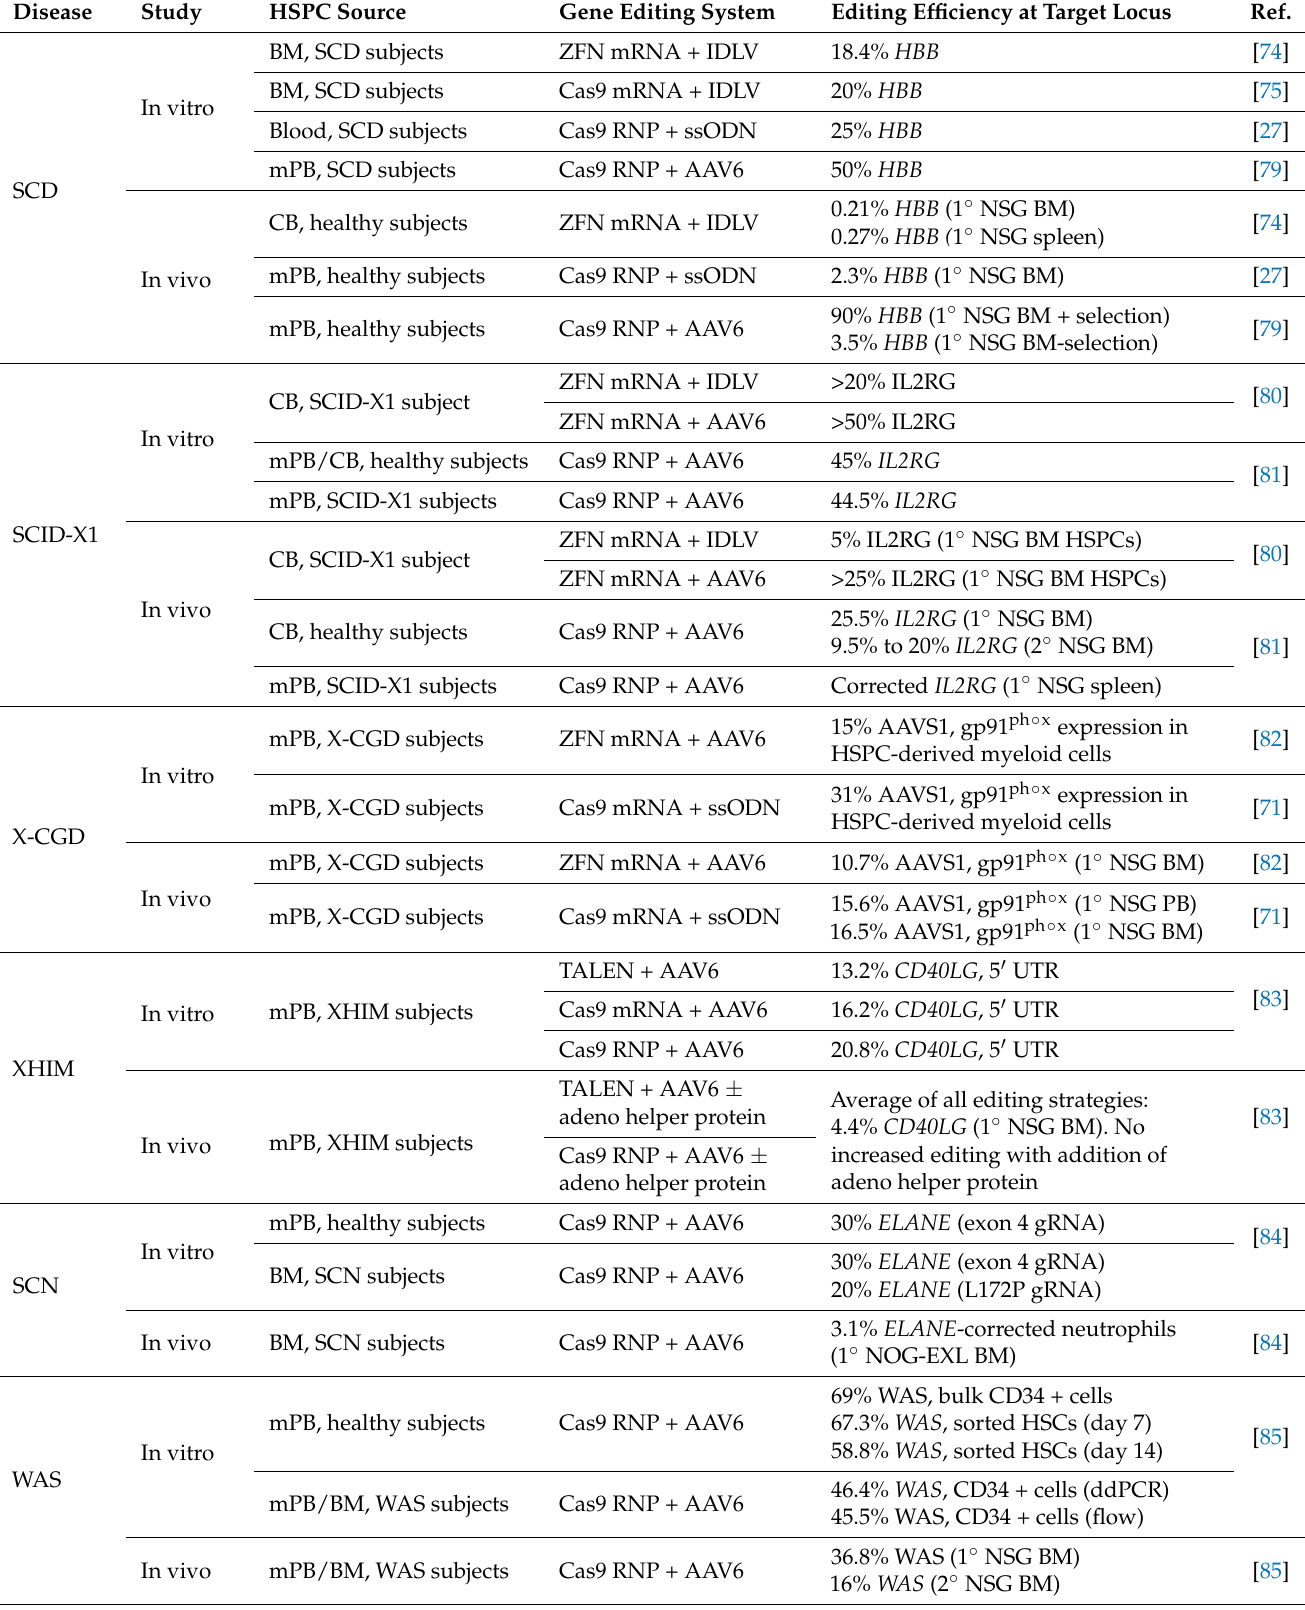
Table 1. HDR-mediated genome editing in HSPCs for inherited